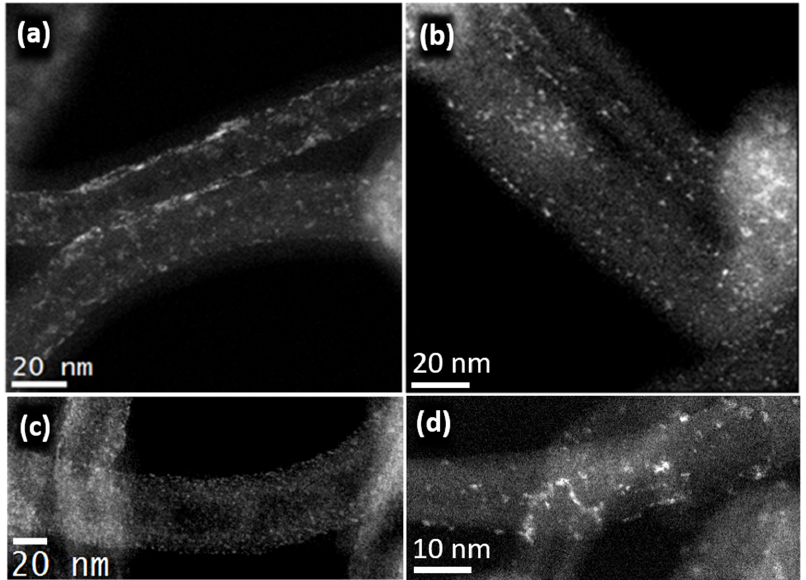
Figure 5. HAADF-STEM images of ( a ) 15 wt. % PW 4 /N-CNTs 1.8 at. % N, ( b ) 15 wt. % PW 4 /CNTs, ( c ) 8 wt. % PV 2 W 10 /N-CNTs (4.8 at. % N), and ( d ) 8 wt. % PV 2 W 10 /CNTs. Adapted with permission from ref. [100] Evtushok et al. Highly efficient catalysts based on divanadium-substituted poly- oxometalate and N-doped carbon nanotubes for selective oxidation of alkylphenols ACS Catalysis 2018 , 8 , 1297–1307. Copyright 2018 American Chemical Society.